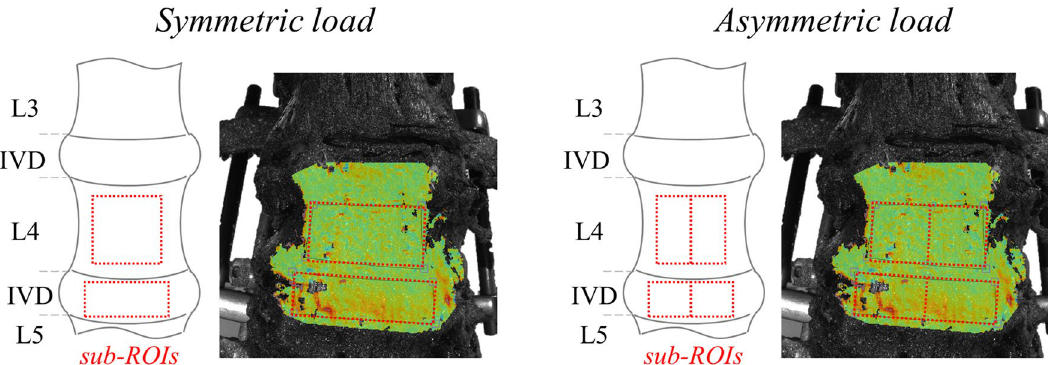
Figure 2. Identification of sub-regions of interest (sub-ROIs) used for median strain values extraction on a representative specimen (Specimen #2, anterior view) and schematic drawing of corresponding spinal structures. One unique sub-ROI was used in flexion–extension (left) in correspondence of the L4 VB (PSO level) and another of the L4-L5 IVD, while two sub-ROIs were used in lateral bending and torsion (right). The DIC strain maps have been obtained using the proprietary software Istra 4D (v4.3.1, Dantec Dynamics, Denmark; URL: https ://www.dante cdyna mics.com/).